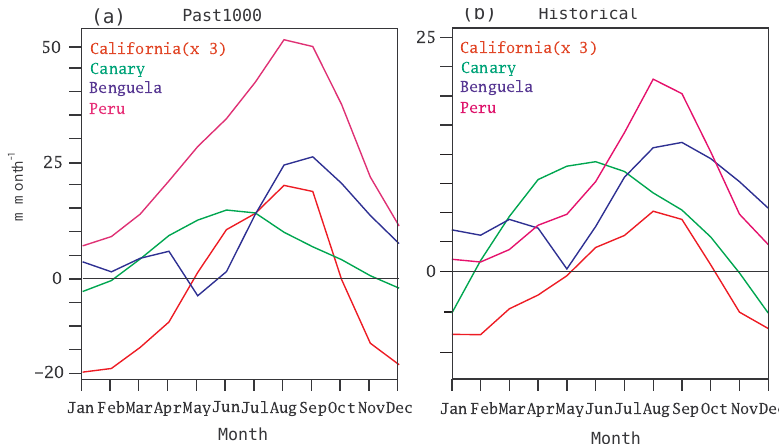
Figure 2. Monthly mean vertical velocity at 52m depth in four main coastal upwelling regions simulated in one past1000 (900–1849) (a) and one historical (1850–2005) simulation ( r 1) (b) of the MPI-ESM. The values for California have been re-scaled for better visibility. Note the different y axis scale for each simulation. As variations of the annual cycle are very small between the simulations of an ensemble, the annual cycle of r 1 represents the simulated annual cycle of all simulations of the ensemble.